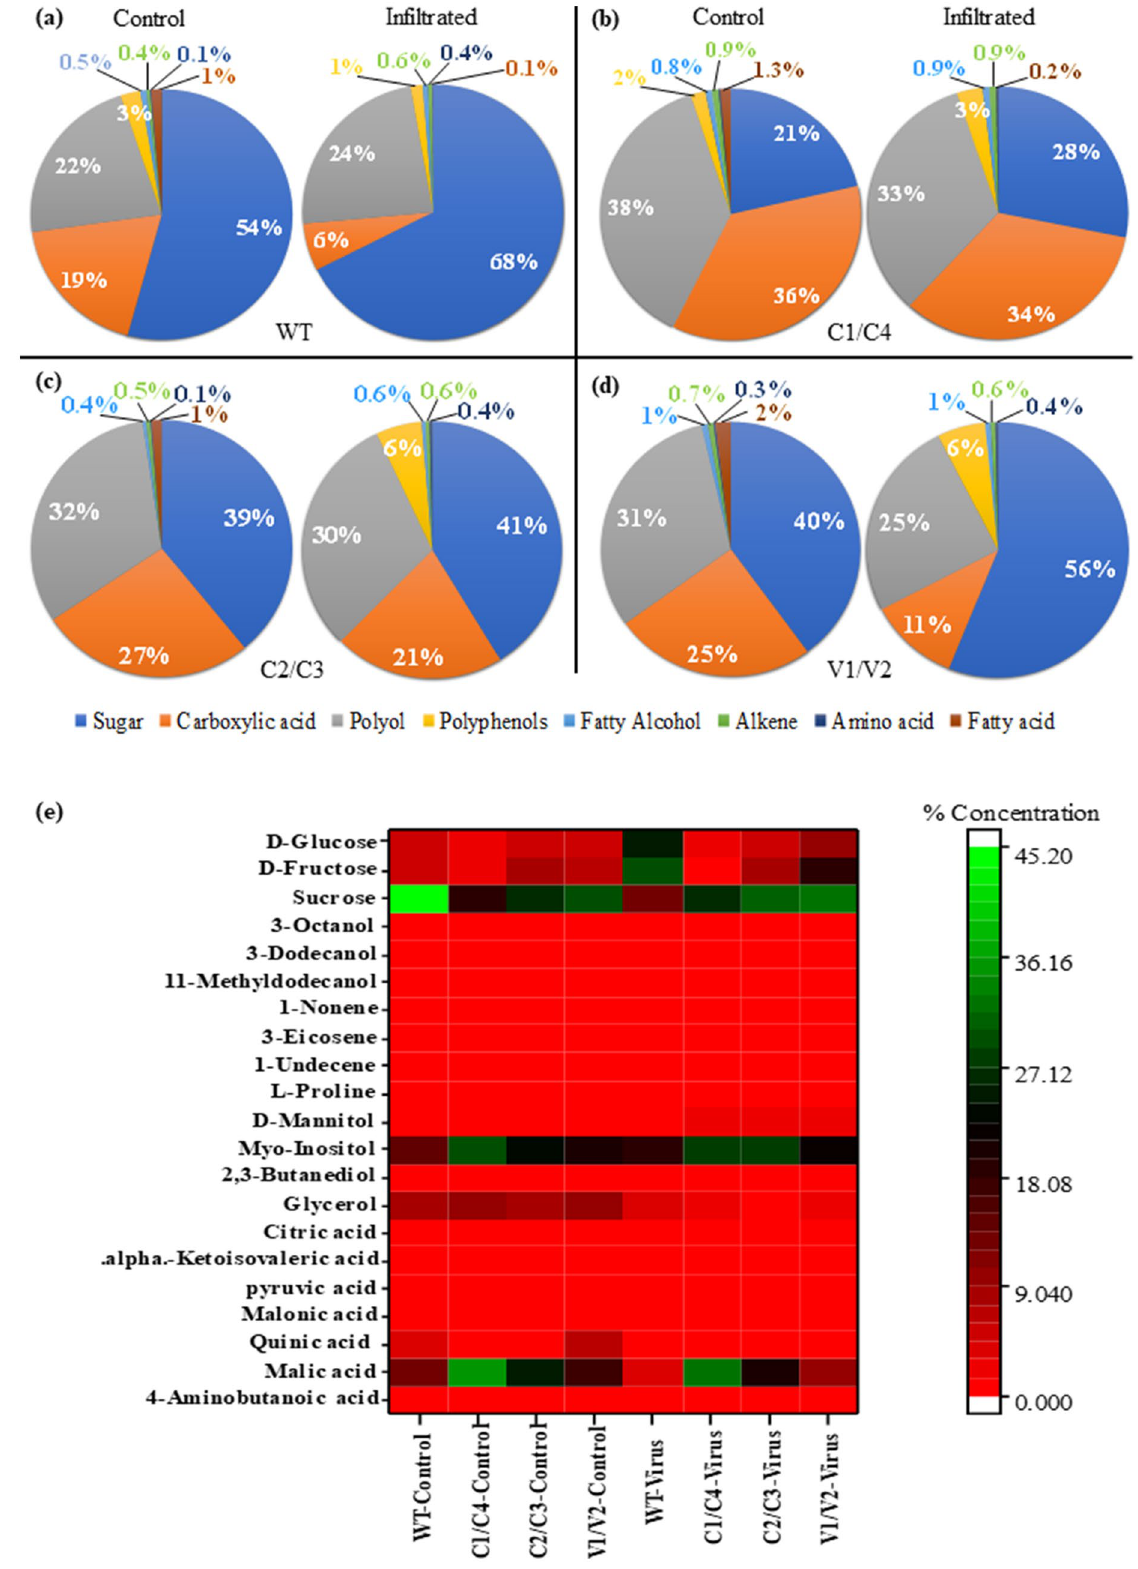
Figure 5. Comparison of different metabolite responses in ( a ) WT, ( b ) C1/C4, ( c ) C2/C3 and ( d ) V1/V2 amiRNA transgenics with and without (control) JLCuGV agroinfiltration, ( e ) heat map of metabolomics with row represents the metabolite and column represents the sample. The metabolite concentrations are shown in different